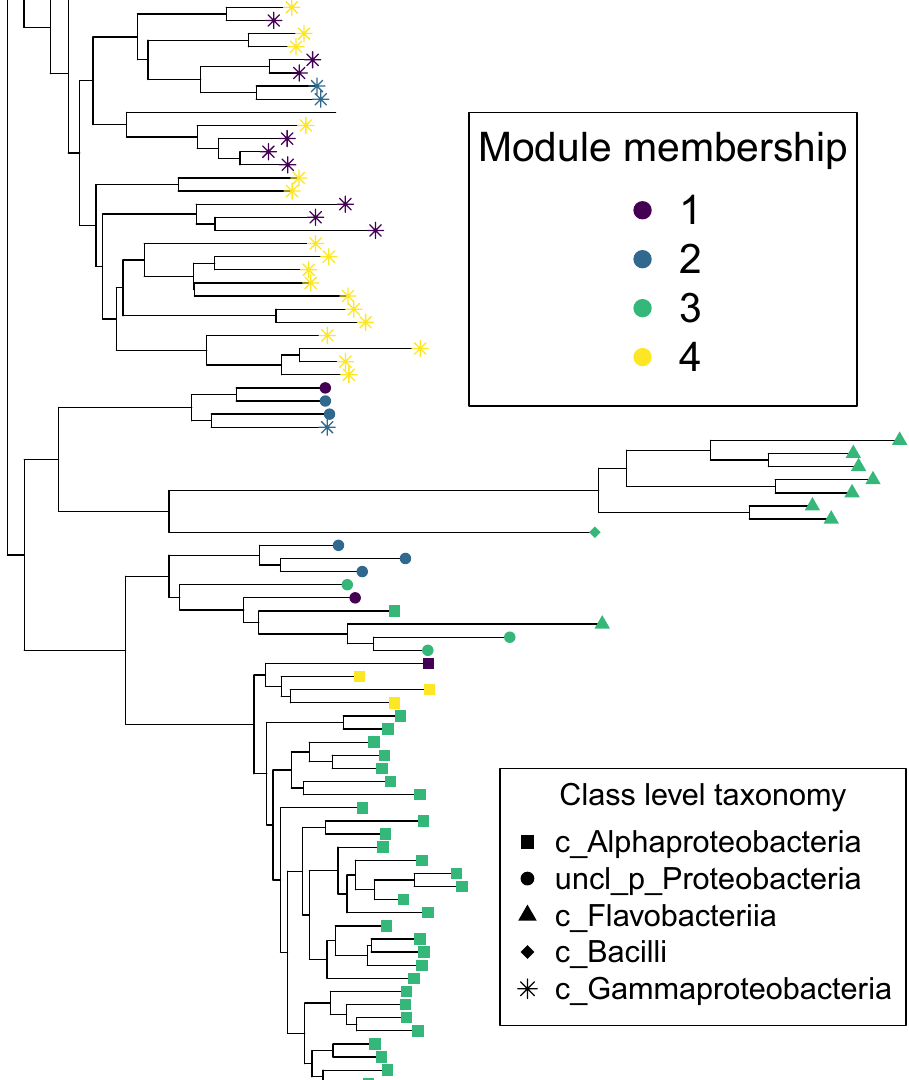
Figure 3. The phylogentic tree of the 86 OTUs from Fig. 2. together with the class level taxonomical assignment. Point colour indicates module membership, whereas the shape indicates class level taxonomical assignment. Notice that there are some inconsistencies between the phylogenetic tree and the assigned